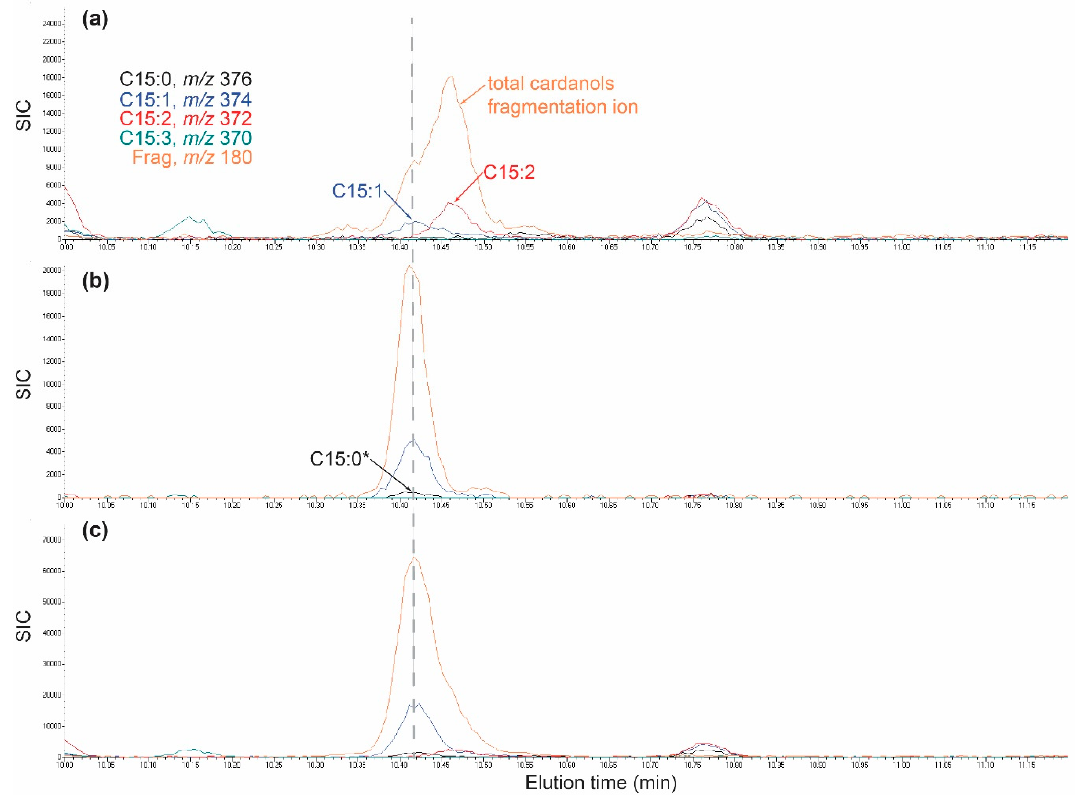
Figure 6. Selective ion chromatograms for C15-cardanols. ( a ) hairy root line HR32-4a. ( b ) 1 ng authentic 15:1-cardanol standard. ( c ) hairy root line HR32-4a extract spiked with 1 ng authentic C15:1-cardanol standard. Dotted vertical line indicates same retention time across all three chromatograms. Each panel has a different Y-axis scale.